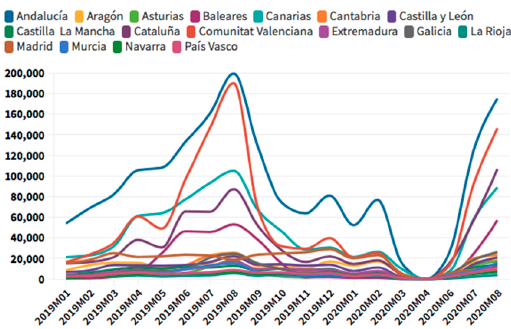
Figure 10. Domestic tourism apartments occupancy. Source: Self-made from INE data.